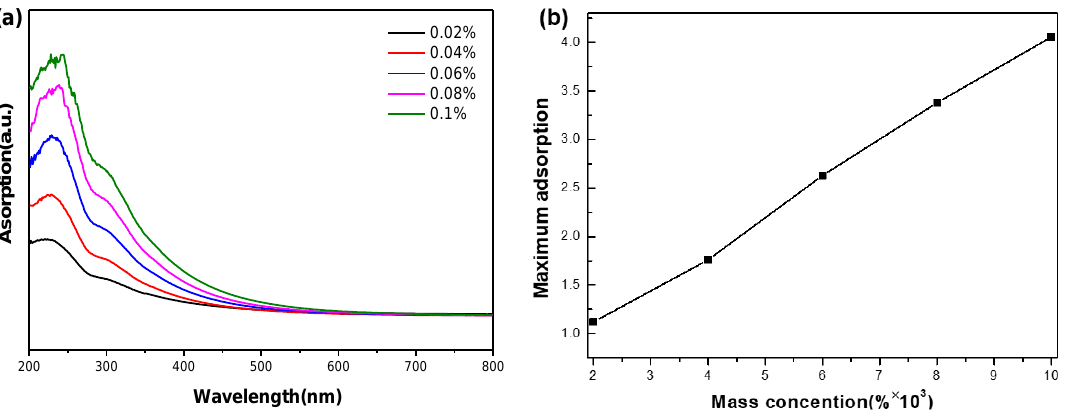
Figure 2. ( a ) UV–Vis absorption spectra of GO nanofluids with different concentrations and ( b ) relationship between mass concentration and maximum absorption.